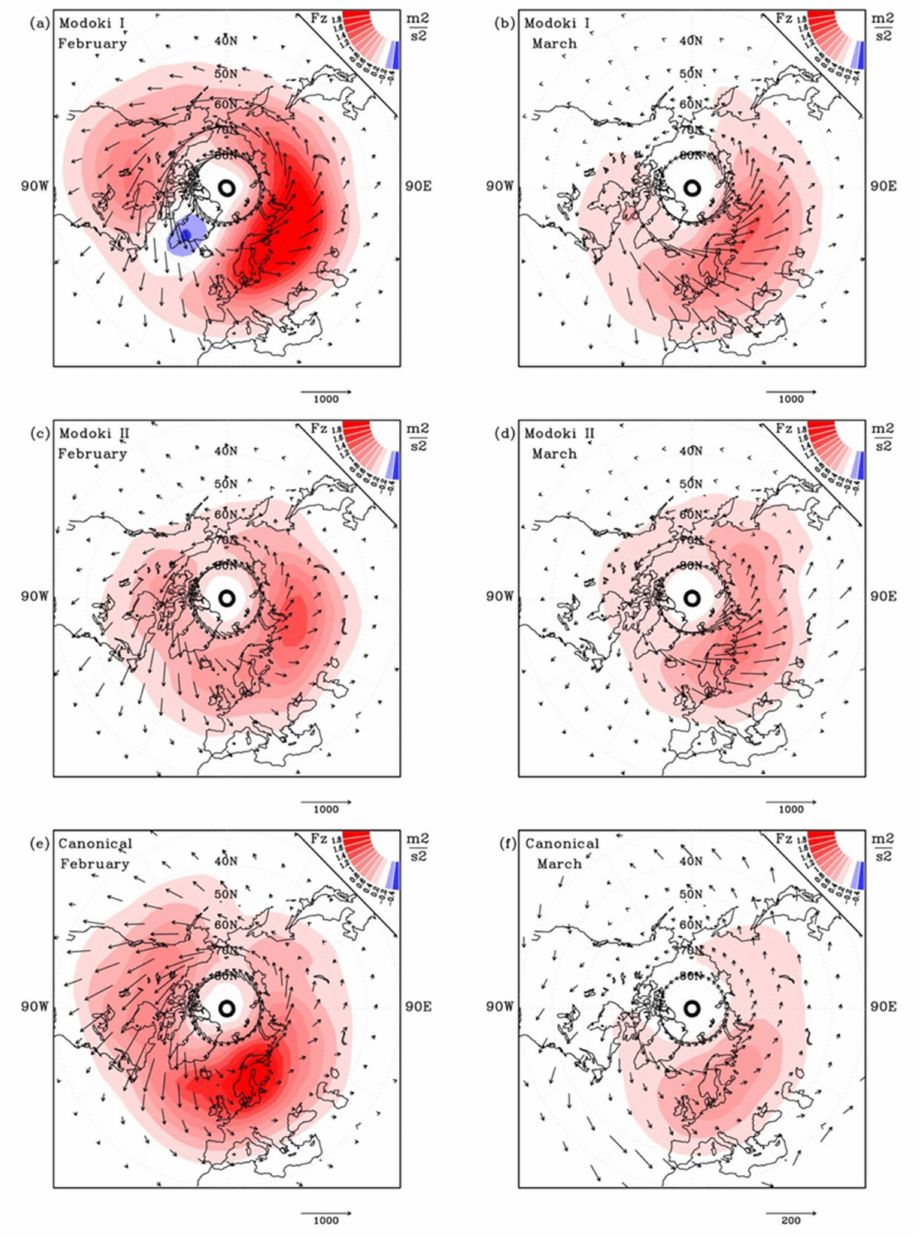
Figure 2. 3D wave activity flux (Fz—shading, [Fx;Fy]—arrows) averaged in February ( left panels ) and in March ( right panels ) at about 40 km during Modoki I conditions ( top panels ), Modoki II conditions ( middle panels ), and canonical conditions ( bottom panels